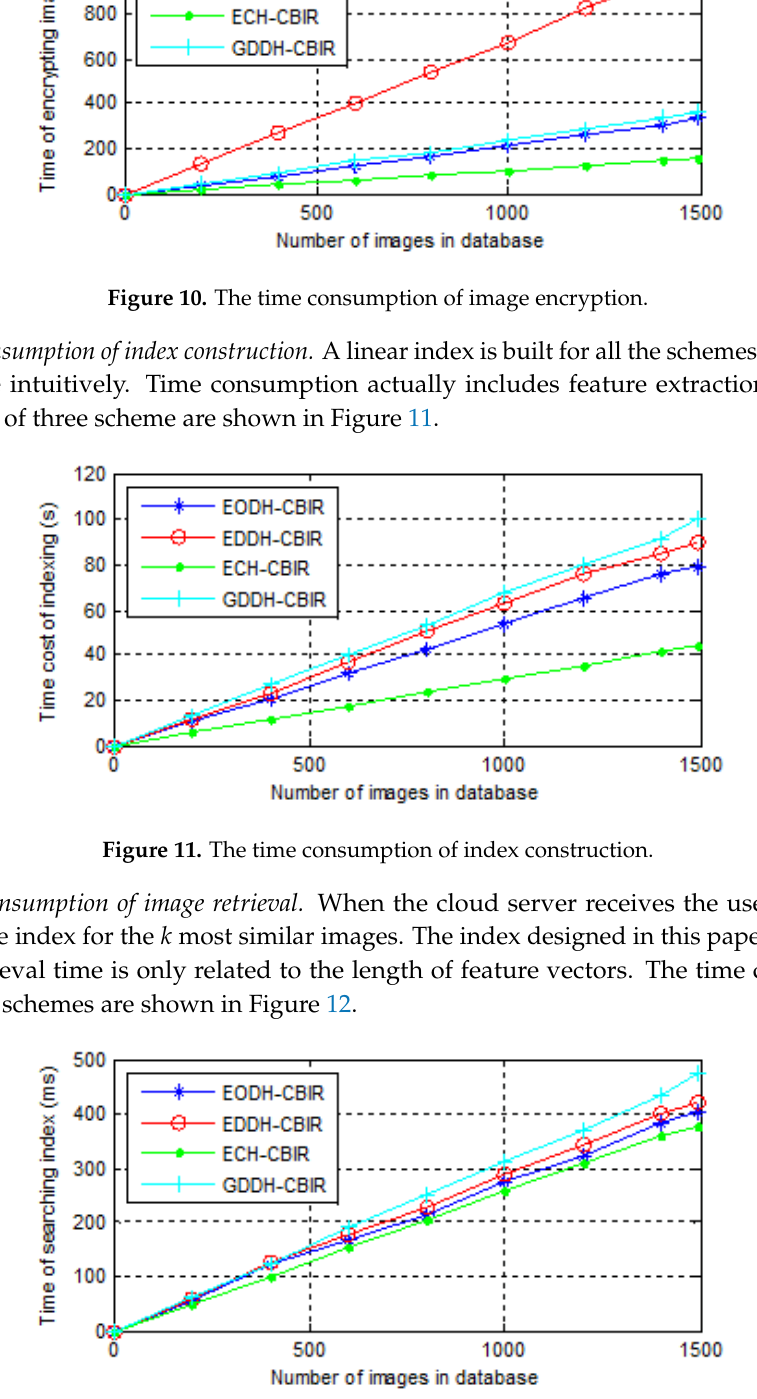
Figure 12. The time consumption of image